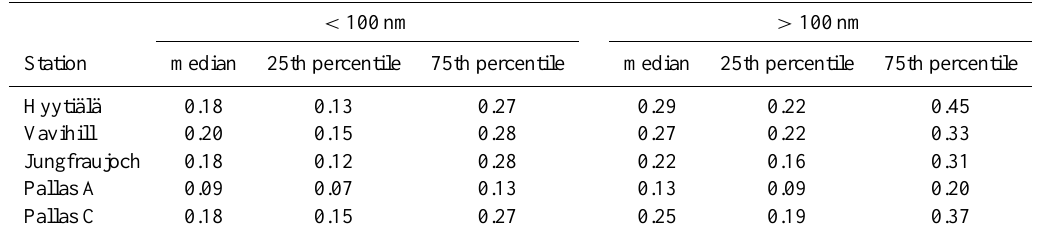
Figure 6. Mean hygroscopicity parameter κ as a function of critical dry diameter D c for selected locations. Figure split in four panels for more detail. Shown with one standard deviation. Table 5. Median and percentile κ values for Aitken ( < 100nm) and accumulation ( > 100nm) mode particles for Hyytiälä, Vavihill, Jungfrau- joch and Pallas A and